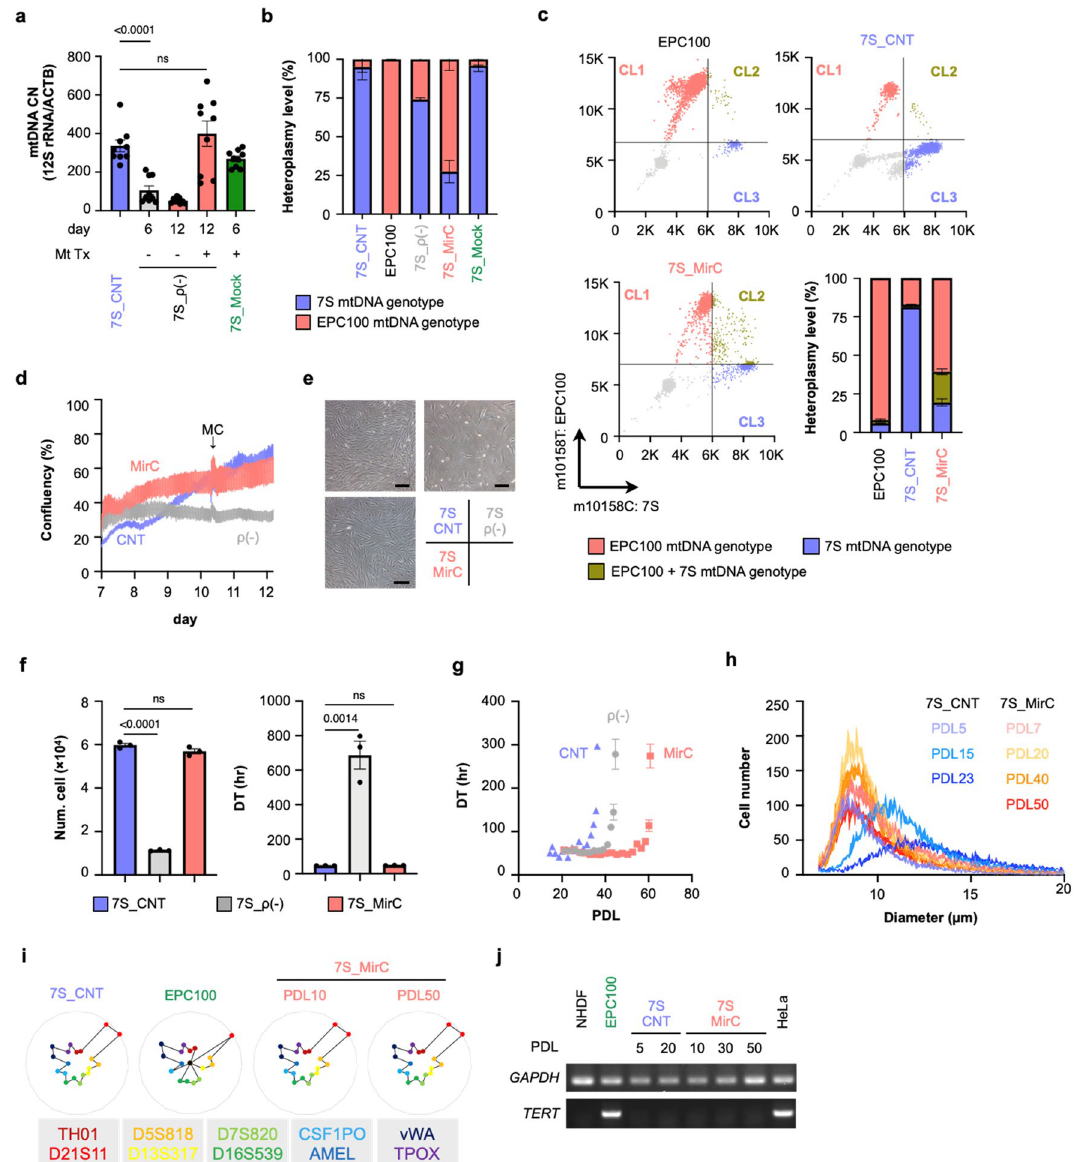
Figure 2. MirCs were generated from mitochondrial disease patient-derived (7S) fibroblasts. ( a ) mtDNA CN during the procedure of MirC generation. Fibroblasts that received gene transfer, designated as 7S_ρ(-) were cultivated with or without isolated mitochondria. Mock transfectants that received a plasmid without the endonuclease, designated as 7S_Mock, were subjected to the same protocol. (n = 9, respectively). ( b ) TaqMan qPCR SNP genotyping assay demonstrated the dominance of exogenous mtDNA. MirCs derived from 7S fibroblasts were designated as 7S_MirC. (n = 3, respectively). ( c ) Heteroplasmic sc-ddPCR discriminated three different populations: healthy homoplasmic cells (Cluster 1: CL1, red), heteroplasmic cells (CL2, brown), and mutated homoplasmic cells (CL3, blue) for mtDNA. Representative analyses are shown in the quadrant plotting, and the averages are depicted as a bar graph. Donor mitochondria for MirCs were isolated from EPC100 cells. (n = 3, respectively). ( d ) Cell growth of MirCs compared with the original cells and ρ(-) cells by using time- lapse imaging recorder from day 7 to day 12 in the protocol. The confluency was automatically calculated by JuLI STAT software. ( e ) Microscopic photographs of cell cultures following mitochondrial replacement 5 days after replating at a concentration of 1 × 10 5 cells on day 12 in the protocol. ( f ) The yield of cells and the doubling time of MirCs were similar to those of 7S fibroblasts. The black bar indicates 200 µm. (n = 3, respectively). ( g ) Long-term culture showed the lifespan extension of MirCs. (n = 3, respectively). ( h ) The cell size of MirCs was maintained during culture, whereas that of the original cells was significantly enlarged from early PDL with time. (n = 3, respectively). ( i ) Short tandem repeats (STRs) demonstrated no contamination of the original MirCs by EPC100 cells that provided the donor mitochondria for MirCs. ( j ) TERT expression in MirCs to deny carcinogenic transformations. The full-length gel of cropped gels is shown in Supplementary Fig. S4. mtDNA, mitochondrial DNA. CNT, no treatment control cell. ρ(-), rho minus, indicates cells with a low mtDNA number. CN, copy number. MC, medium change. DT, doubling time. PDL, population doubling